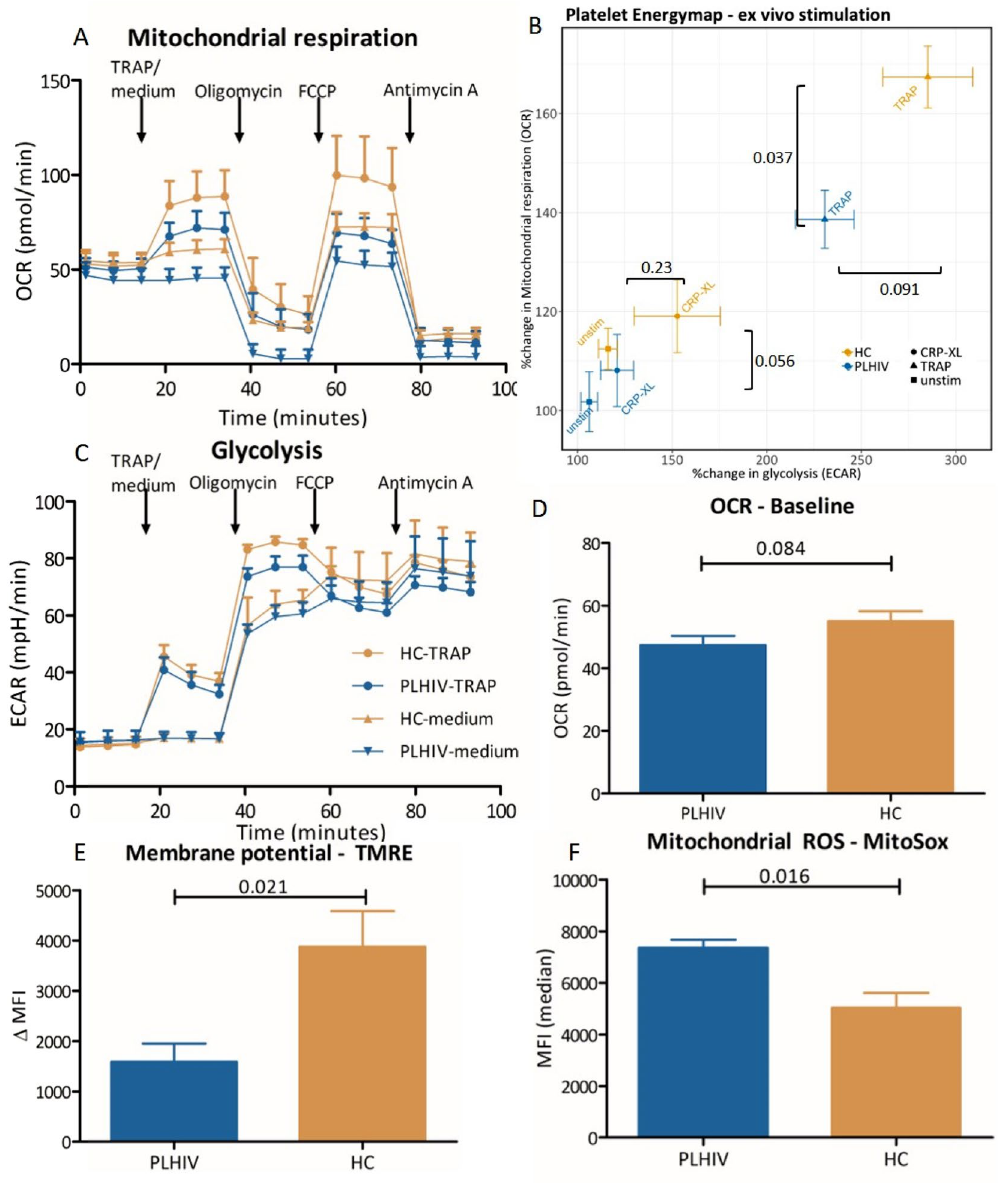
Figure 2. Platelet energy phenotype determined by the Seahorse extracellular flux analyzer and mitochondrial membrane potential and ROS production. Samples were measured with five replicates, 1 × 10 7 washed platelets per well. Five age-and sex-matched donors per group. ( A ) Real-time mitochondrial respiration depicted as oxygen consumption rate (OCR) at 18 timepoints. Four agonists or inhibitors were added in the following order: (1) Thrombin Receptor Activator Peptide-6 (TRAP-6; 50 µM) or medium causing platelet activation; (2) Oligomycin which inhibits cellular ATP production; (3) Carbonyl cyanide-4-(trifluoromethoxy) phenylhydrazone (FCCP), an uncoupling agent causing maximum oxygen consumption through complex IV, and (4) Antimycin A which inhibits all mitochondrial respiration (CRP-XL can be found in Supplemental Fig. 9). ( B ) Energymap showing the change in mitochondrial respiration (as change in OCR) and glycolysis (extracellular acidification rate (ECAR) from basal conditions after ex vivo stimulation with platelet agonists. (( A )) Depicts the real-time ECAR after (1) medium or TRAP-6 (2) oligomycine, (3) FCCP and (4) antimycin A. Samples were measured with five replicates, 1 × 10 7 washed platelets per well. Five age-and sex-matched donors per group. ( D ) Basal OCR as mean of first three measurements. ( E ) Membrane potential was determined using Tetramethylrhodamine ethyl ester (TMRE) staining with the uncoupler FCCP disrupting mitochondrial membrane potential as a negative control for every sample. Data depicted as delta geometric mean fluorescence intensity (MFI). ( F ) Mitochondrial ROS production with MitoSox staining in MFI. Data are depicted as mean ± standard error of the mean (SEM) and analyzed using the unpaired student’s